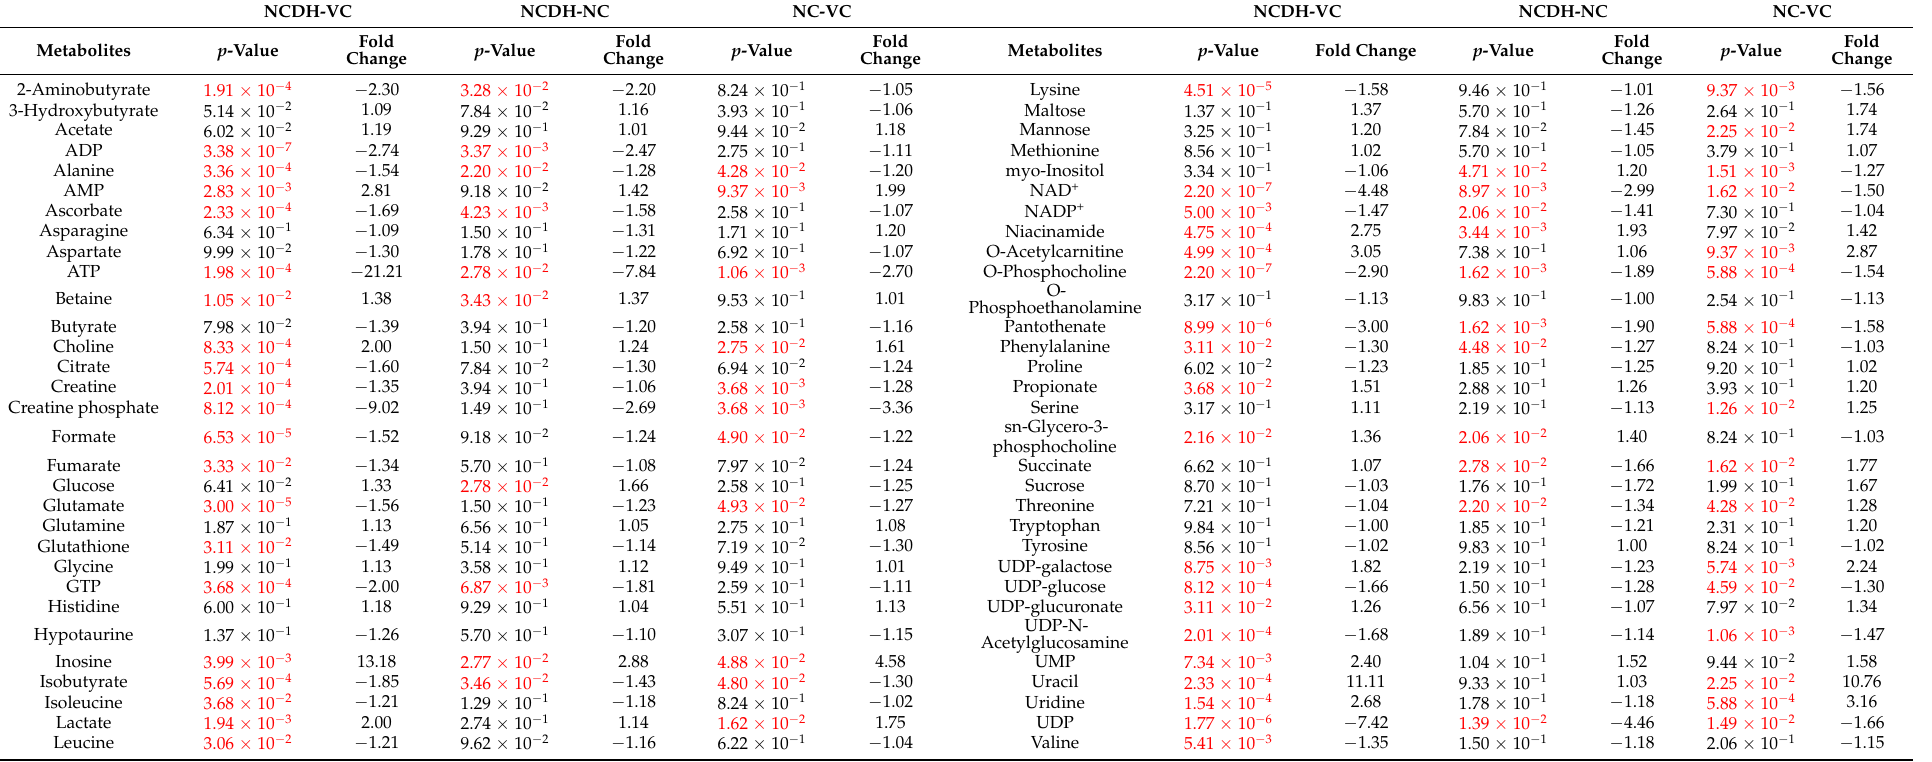
Table 1. Comparisons of metabolites detected in lung tissue samples using Hydrogen-1 Nuclear Magnetic Resonance (1H NMR) metabolomics. The 62 metabolite changes in each pair-wise comparison are listed with p -values based on the Student’s t -test with false discovery rate (FDR) correction ( p < 0.05 in red). The fold changes are calculated by NCDH/NC, NCDH/VC, and NC/VC, where the fold change > 1 indicates the increase and <1 indicates the decrease compared to the control group. If the fold change is <1, the negative reciprocal is listed.